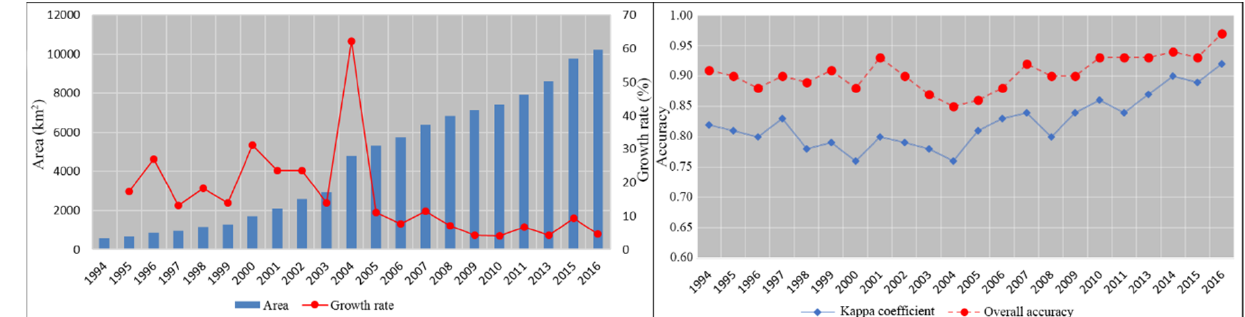
Figure 5. ( a ) Total impervious surface area (ISA) quantity and growth rate in the GHM Bay Area in each year; ( b ) the overall accuracy and Kappa coefficient of each impervious surface map from 1994 to 2016.